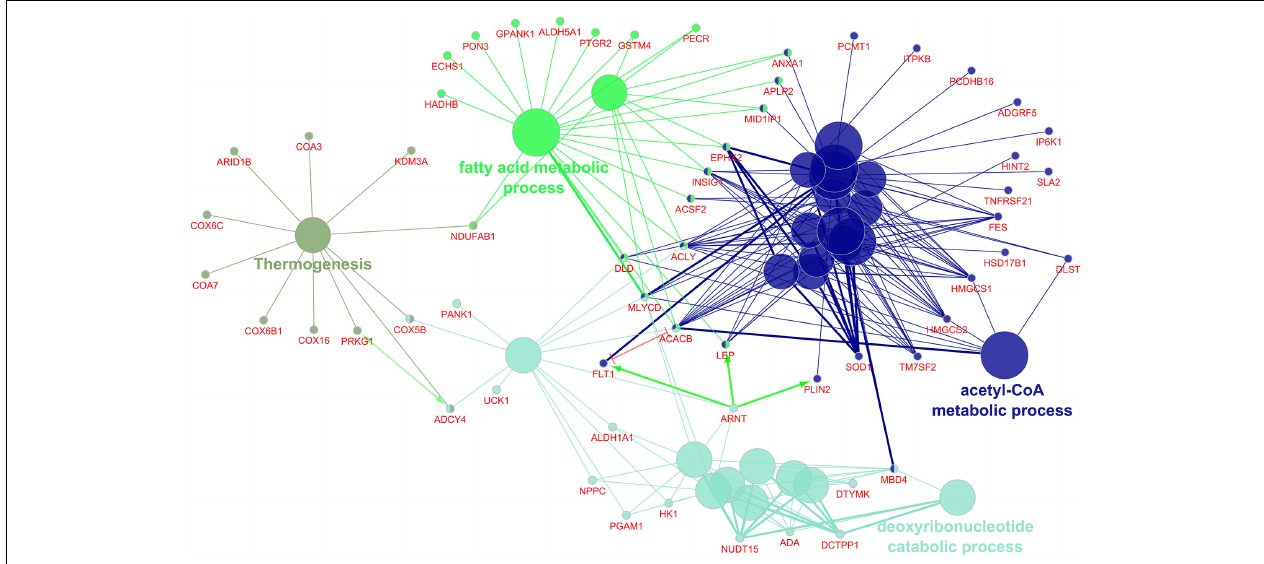
FIGURE 3 | Enriched ClueGO gene network from the epicardial adipose tissue. Similar gene ontology or KEGG pathway terms are clustered by color and the representative term for those clusters are presented. Gene names shown in red; Green lines with arrows represent gene activation interactions; Red lines with bars represent interactions involved in gene repression.